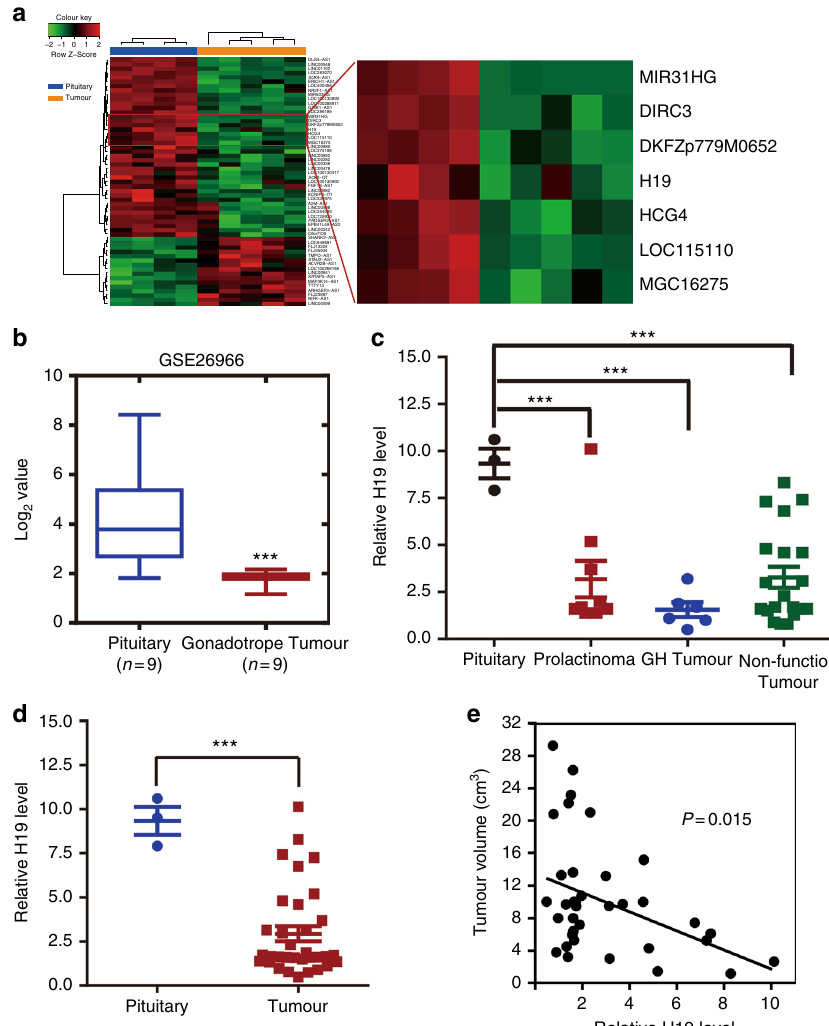
Fig. 1 H19 expression is decreased in pituitary adenomas. a H19 expression is decreased in human prolactinomas compared with that in normal pituitary glands from healthy subjects. The SurePrint G3 Human GE 8 × 60 K Microarray was used to pro fi le lncRNA expression in human normal pituitary glands and prolactinomas (GSE119063). Heatmap showing the differential expression of lncRNAs in normal pituitary ( n = 4) and prolactinomas ( n = 5), including the decreased level of H19 in prolactinomas. Right box plot panel shows that H19 expression is decreased approximately 1.51-fold in prolactinomas. b H19 expression is decreased in human gonadotropic adenoma (GEO dataset GSE26966). Statistical signi fi cance was determined by one-way ANOVA followed by Tukey ’ s multiple comparison test. *** p < 0.001. c Decreased expression of H19 in prolactinomas, GH tumours and nonfunctioning pituitary tumours compared with that in three normal pituitary tissues. Statistical analysis was determined by paired Student ’ s t -test. *** p < 0.001. d H19 is decreased by 3.24-fold in 37 pituitary tumours compared with that in three normal pituitary tissues. Total RNA was extracted from 37 different subtypes of human pituitary tumours, and qRT-PCR was performed to assess H19 abundance in these pituitary adenomas (PRL = 9, NFPA = 20, GH = 6, ACTH = 2); mRNA levels were normalized to β -actin mRNA. *** p < 0.001, two-tailed Student ’ s t -test was used for statistical analysis. e H19 expression level is